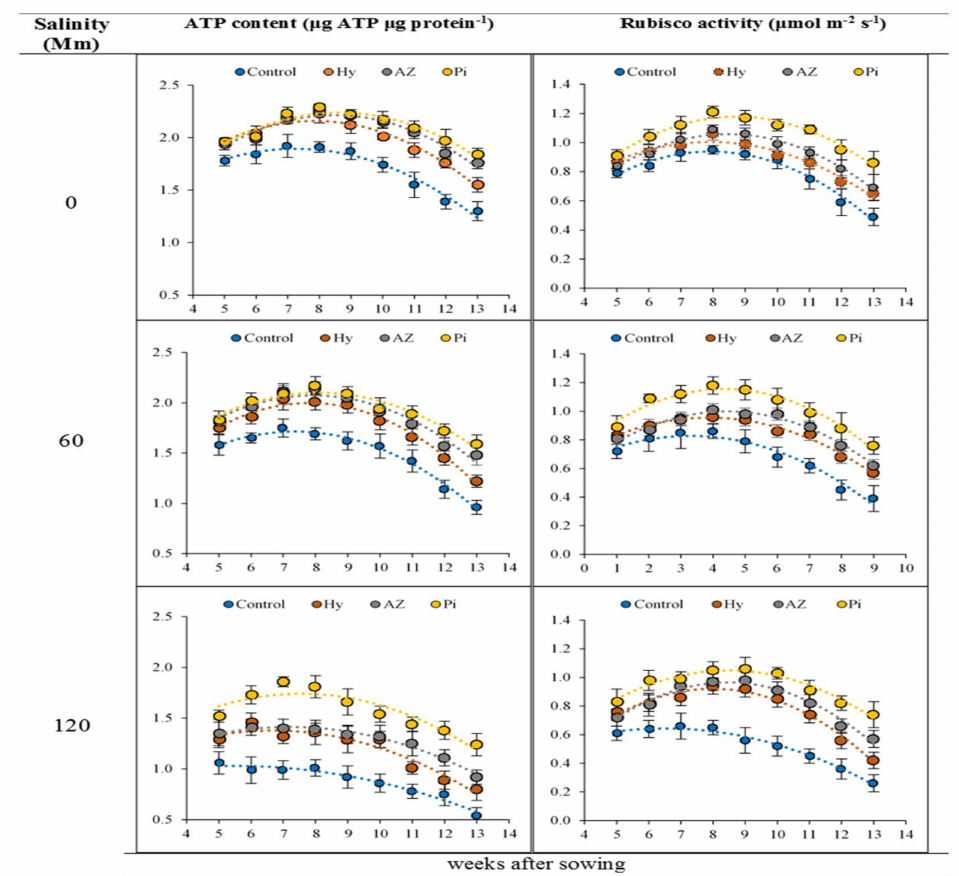
Figure 3. Changes in ATP content and rubisco activity in milk thistle leaves in response to salinity stress (0, 60 and 120 mM) and seed priming. Values mean of four replicates ± SD. Hydro: hydro- priming, Az: Azotobacter chroococcum and Pi: Piriformospora indica .